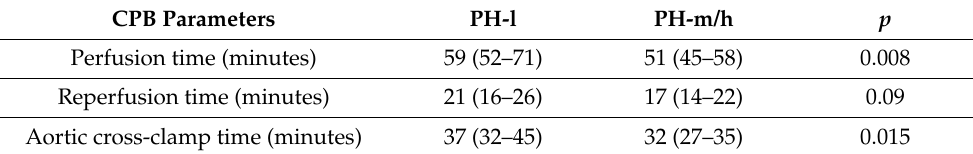
Table 5. Cardiopulmonary bypass (CPB) surgery